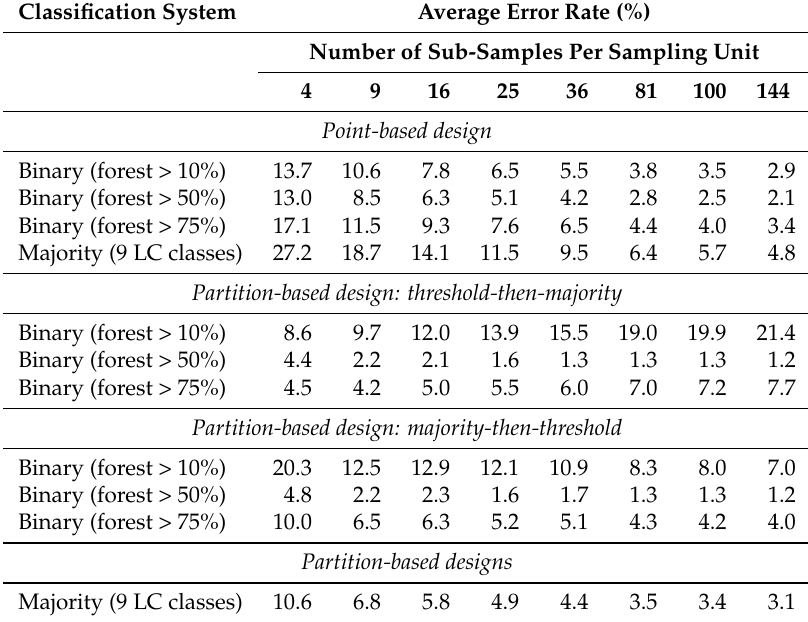
Table 1. Average error rate in reference labels across the study area for point-based and partition- based designs. The binary maps on which the test was performed define the forest class based on the percentage of tree cover. The other type of map (called majority) includes 9 land-cover (LC) classes assigned based on the class that covers the largest area inside the sampling unit. The two types of partition-based designs are identical when the classification system is a majority